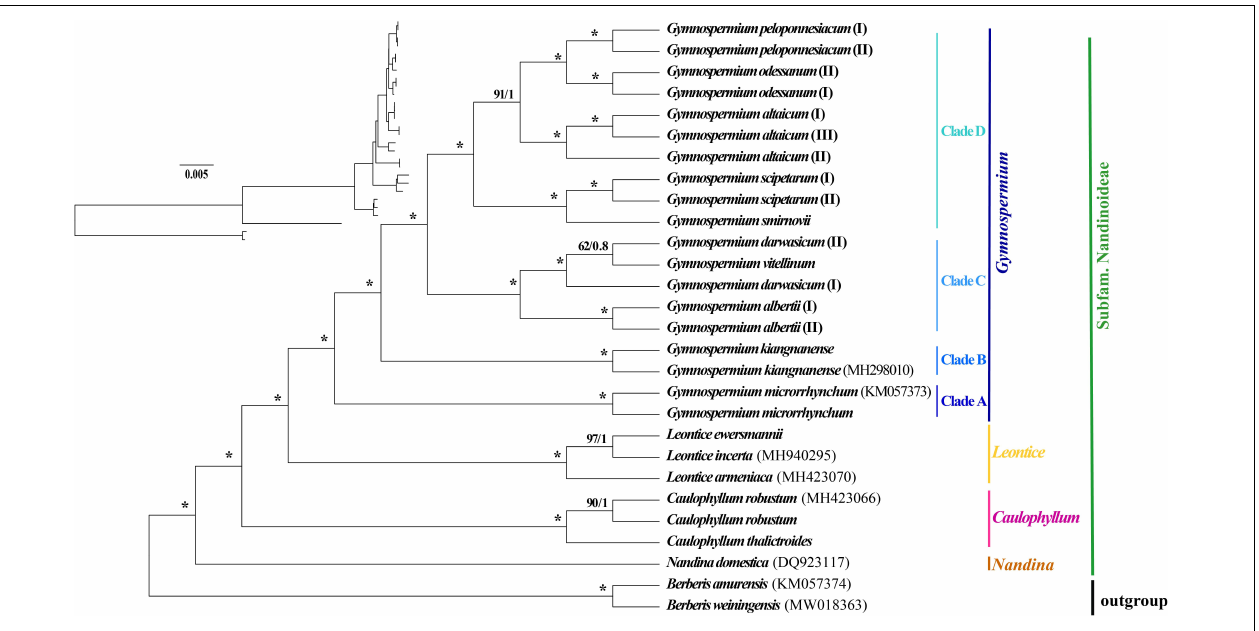
FIGURE 5 | Phylogenetic tree reconstructions of 16 species of Nandinoideae ( n = 26 accessions) plus two outgroup species of Berberis based on 80 plastome-derived CDS genes inferred from maximum likelihood (ML) and Bayesian inference (BI), respectively. Consecutive numbers at each node represent ML bootstrap support (BS) and BI posterior probability (PP) values, respectively. Asterisks indicate maximum support by both measures (i.e., BS = 100%/PP = 1).